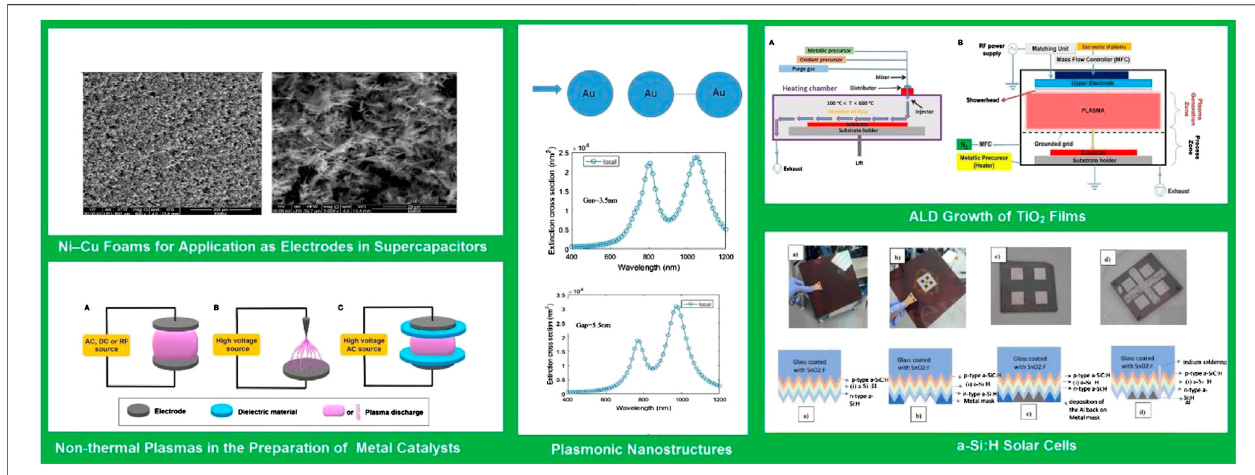
FIGURE 1 | Illustration of the themes addressed in the research topic nano fi lms and nanostructures for energy applications.